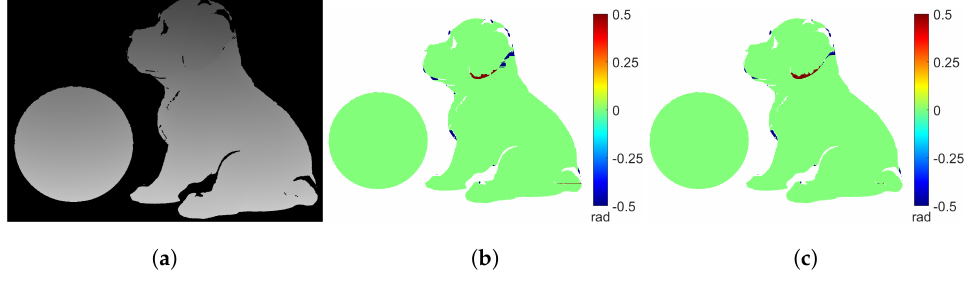
Figure 8. Comparison of the absolute phase maps obtained from unwrapping φ with the DIC − assisted method, our proposed method, and the multi − wavelength method. ( a ) Absolute phase map from the multi − wavelength method. ( b ) Difference map between Figure 7c and ( a ) (3615 error points). ( c ) Difference map between Figure 7f and ( a ) (2997 error